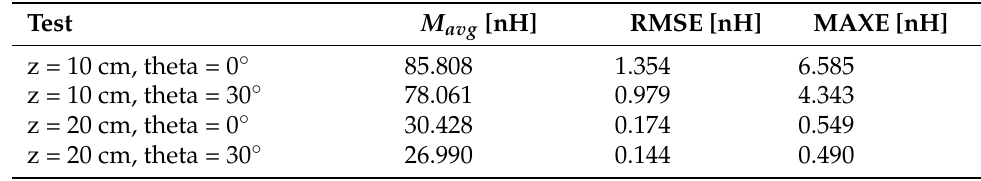
Table 2. Each test includes 392 mutual inductance values, with average M avg . RMSE and MAXE are calculated between the measurement and the model proposed in Section 2.